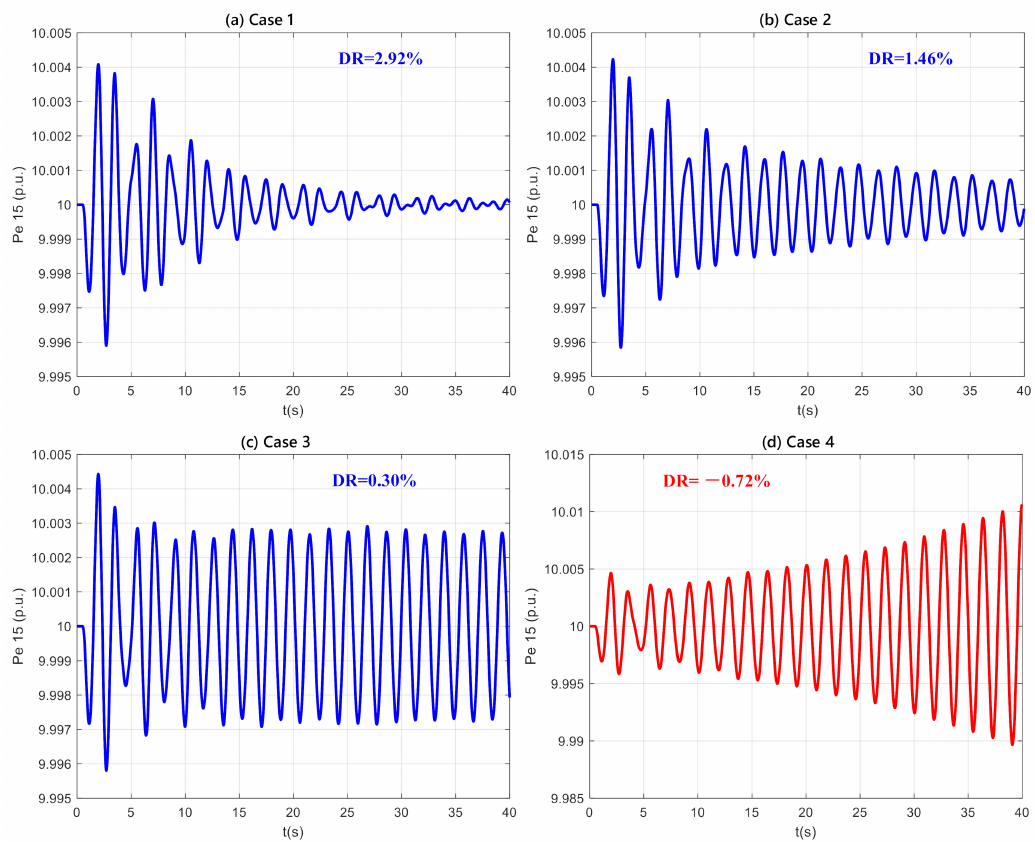
Figure 11. Rotor speed difference between 13th SG and 15th SG in four Cases. ( a ) Case 1; ( b ) Case 2; ( c ) Case 3; ( d ) Case